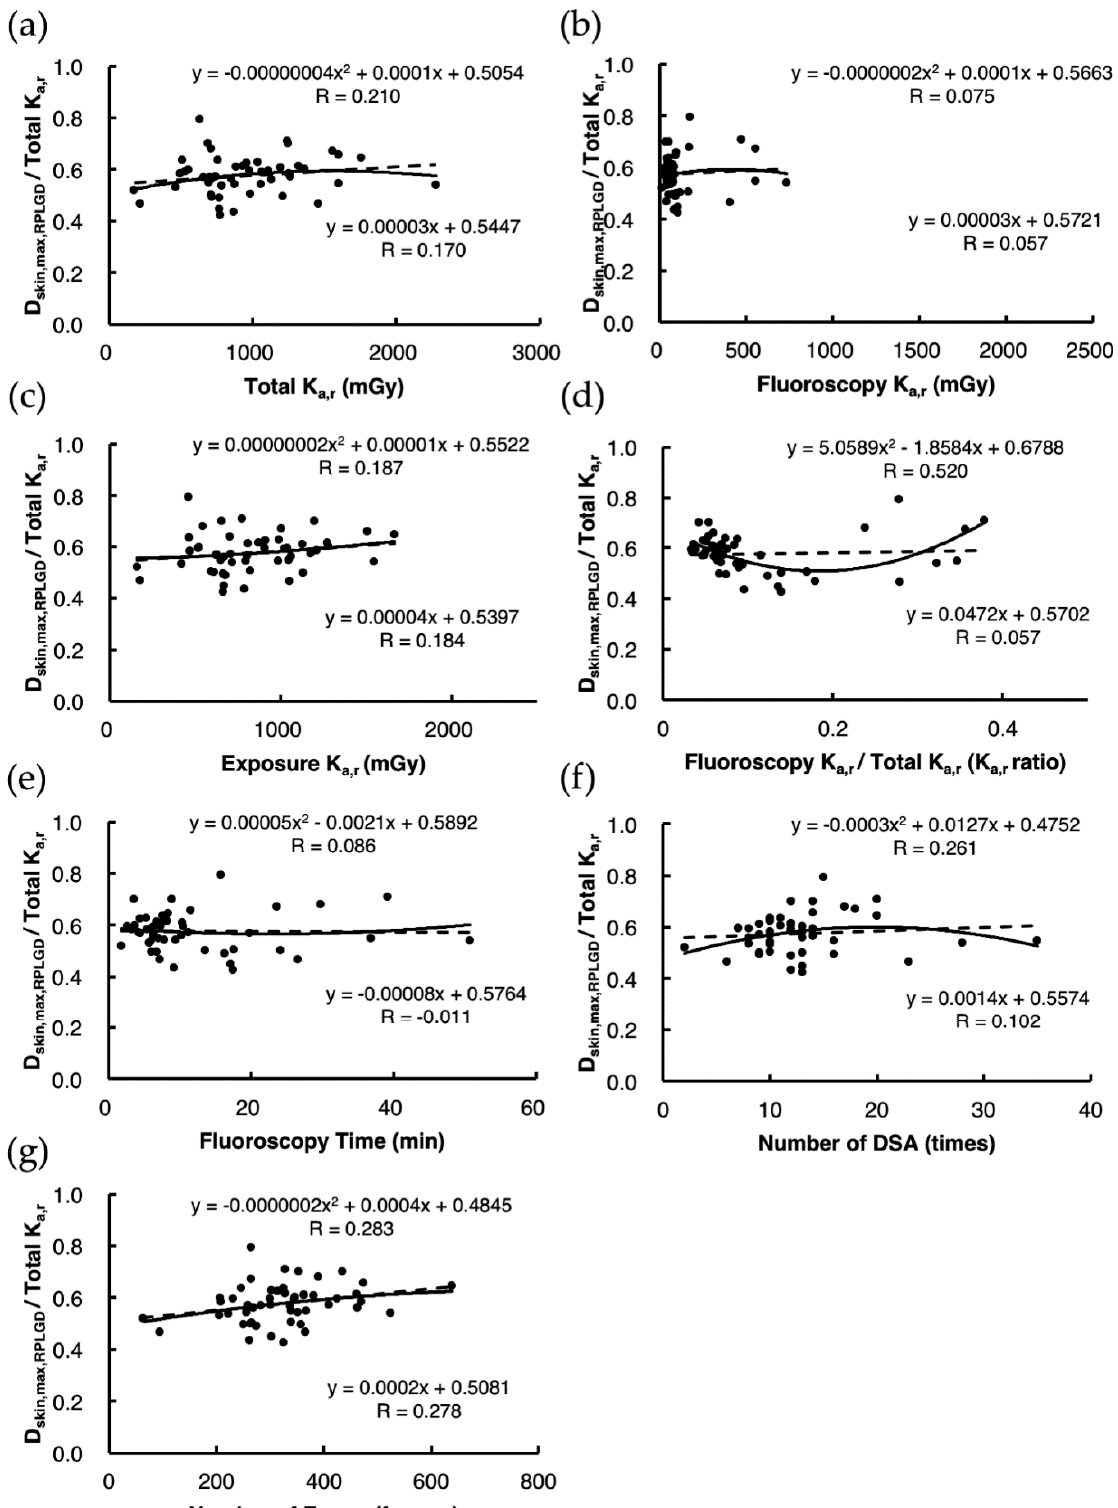
Figure 2. Analysis of factors affecting D skin,max,RPLGD /Total K a,r using the test data set ( n = 50). The broken lines indicate linear regression, and the solid lines indicate quadratic regression. We analyzed the correlations between D skin,max,RPLGD /Total K a,r and the following DICOM-RDSR parameters: ( a ) Total K a,r ; ( b ) Fluoroscopy K a,r ; ( c ) Exposure K a,r ; ( d ) Fluoroscopy K a,r /Total K a,r (K a,r ratio); ( e ) Fluoroscopy Time; ( f ) Number of DSA; ( g ) Number of frames.